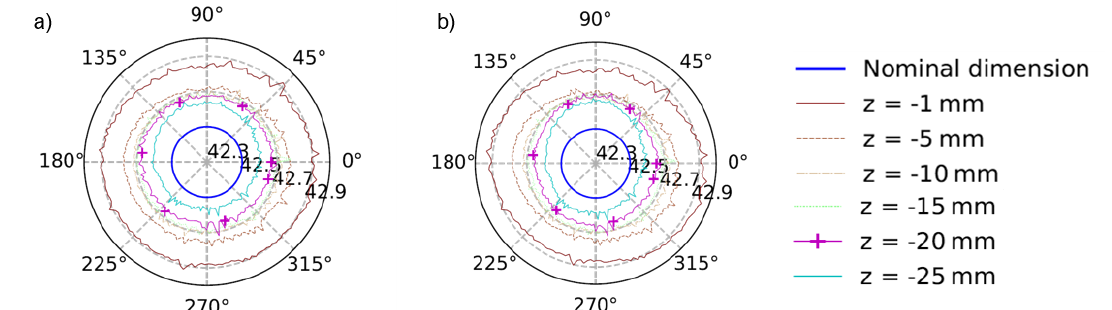
Figure 6. Dependence of the outer radius on height and angle, measured from specimen D85 stripe strategy: ( a ) before and ( b ) after separation.